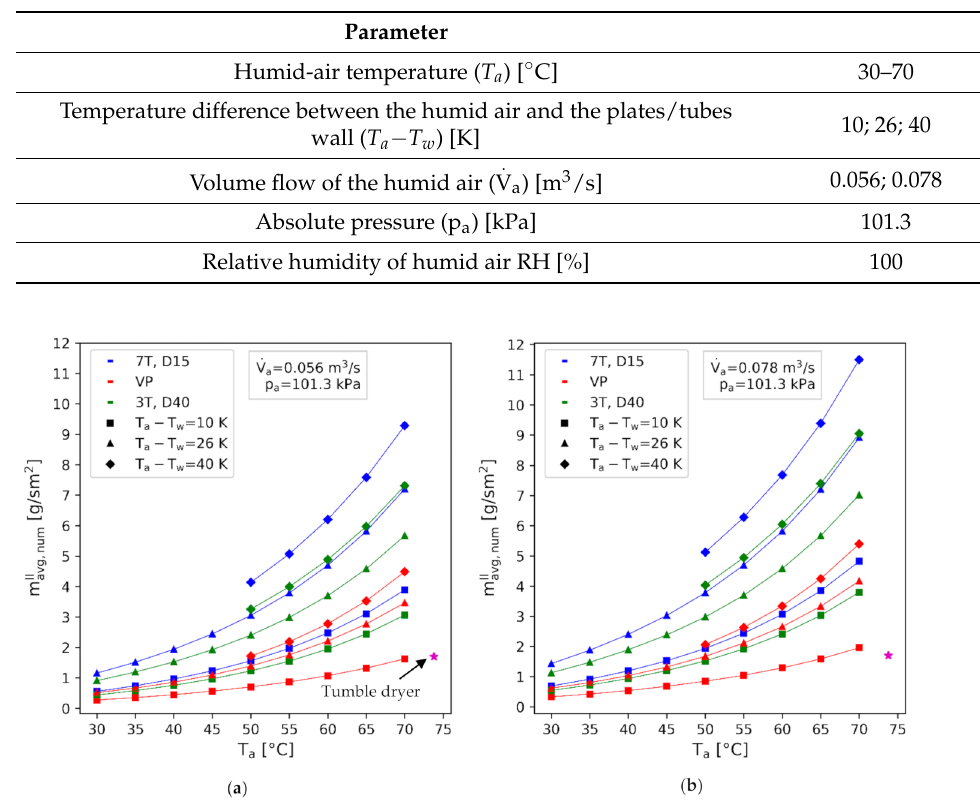
Figure A2. Condensation mass fluxes, calculated on the basis of corrected correlations for the presented geometries based on three and seven tubes and vertical flat plates in relation to the temperature difference between the humid air and the tube/plate wall, humid-air temperature and volume flows of humid air of ( a ) 0.056 m 3 /h and ( b ) 0.078 m 3 /s. The magenta star denotes the condensation mass-flux rate of the existing condenser in the tumble dryer for process parameters described in Appendix